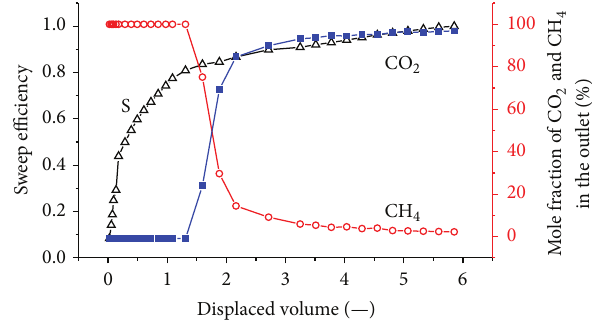
Figure 6: The sweep efficiency and concentrations of produced gas against displaced volume at 1.8 MPa.